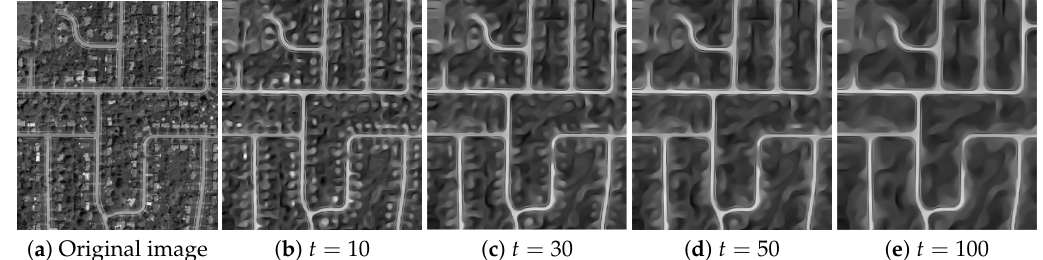
Figure 2. ( a ) the original aerial image and the resultant images obtained using the proposed method (i.e., recursive anisotropic diffusion) with the scales ( b ) t = 10, ( c ) t = 30, ( d ) t = 50, and ( e ) t = 100. The linear features corresponding to roads are better characterized as the anisotropic scale increases while the linear features are